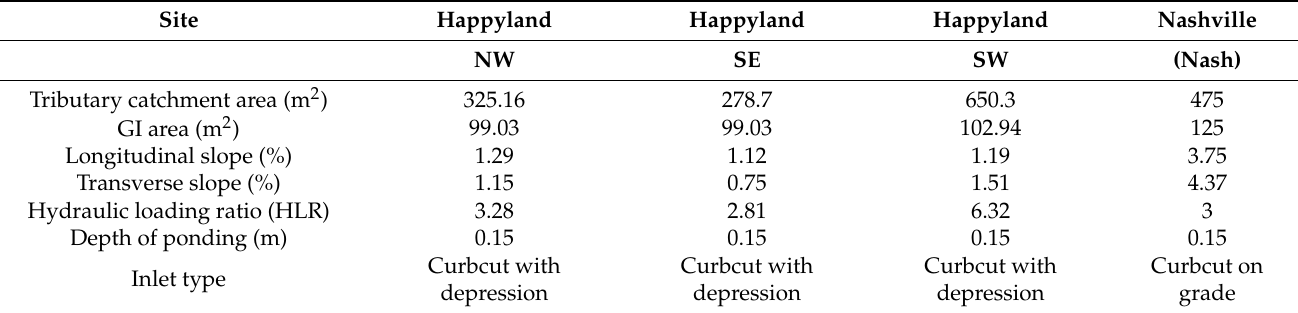
Table 1. Site characteristics.